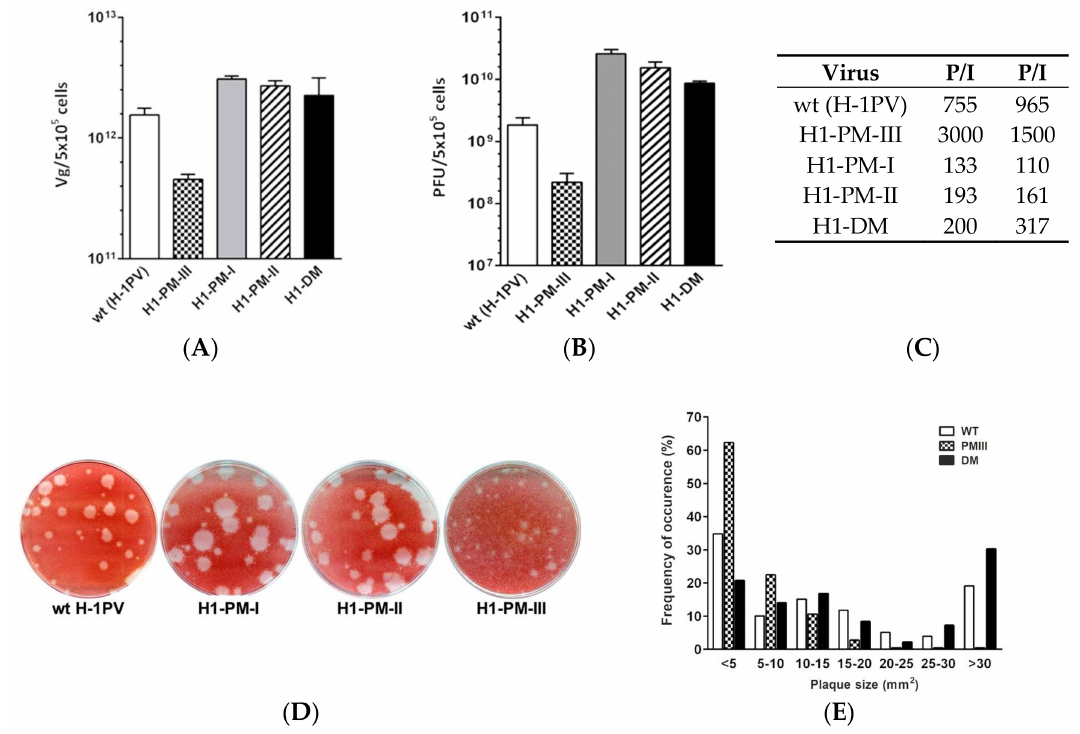
Figure 1. Enhanced infectivity and spreading capacity of H1-PM-I, -PM-II, and –DM, but not of H1-PM-III, compared to wild-type H-1PV in NB-324k cells. ( A ) Progeny virus production infectivity in human NB-324k cells. NB-324k cells infected with wild-type (wt) H-1PV, H1-PM-I, H1-PM-II, H1-PM-III, or H1-DM (MOI, 3 × 10 -3 PFU/cell) were harvested at day 5 post-infection. Titers of full particles (given in Vg/mL) ( A ) and infectious virus (in PFU/mL) ( B ) were determined after virus purification by qPCR and plaque assay, respectively. The particle-to-infectivity ratio (P/I) ( C ) of the virus stocks is indicated. Results are given from two independent experiments. ( D , E ) Plaque size and frequency of occurrence after infection of NB-324K cells. Plaque assays were performed on wt, H1-PM-I-, H1-PM-II- ( D ) or wt, H1-PM-III-, and H1-DM-infected NB-324k cells ( D , E ) and the plaque sizes of wt, H1-PM-III-, and H1-DM-infected cells ( E ) were determined from scanned pictures